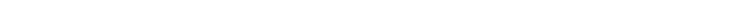
Algorithm 3 Population size.